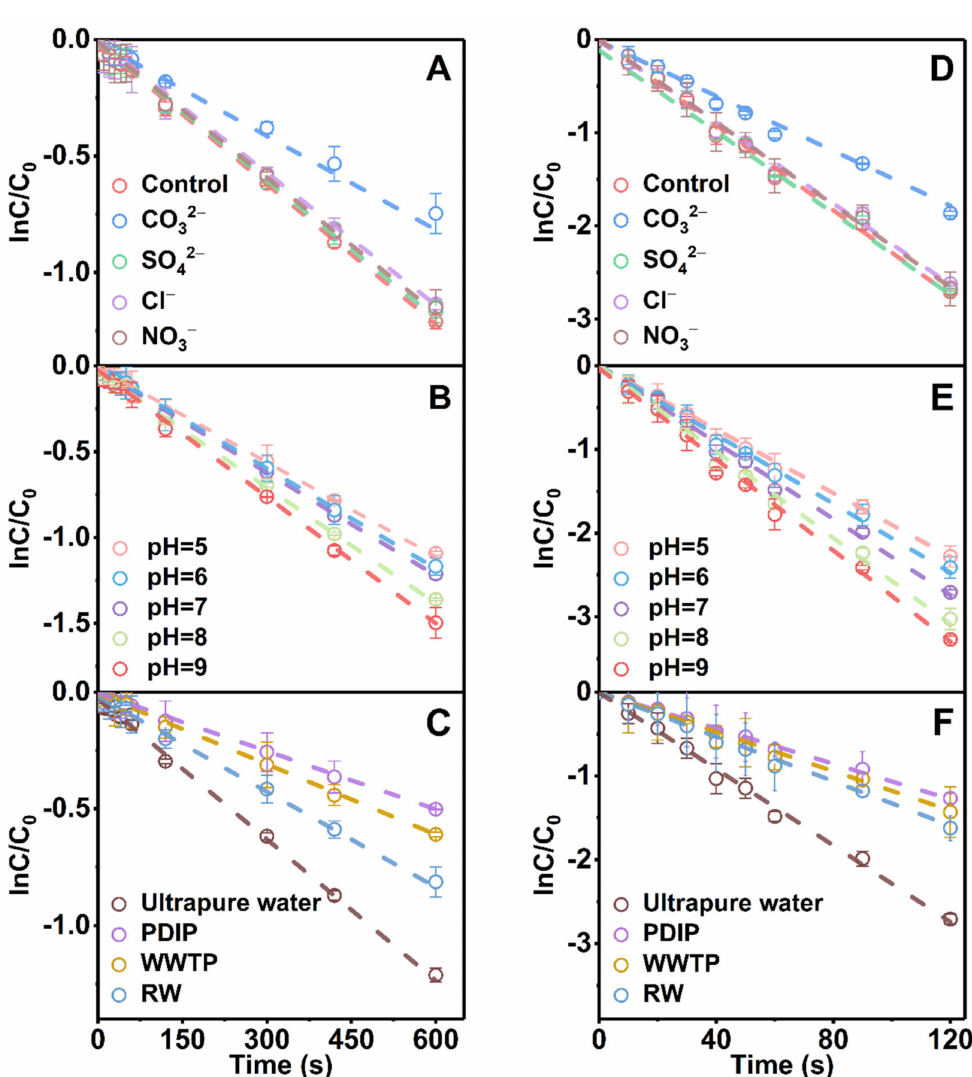
Figure 5. The degradation of DMP and 1 − NP in presence of different ions (CO 32 − , SO 42 − , Cl − , NO 3 − , 2 mM) ( A , D ), at pH of 6 − 9 ( B , E ), in different real water samples (ultrapure water, PDIP effluent, WWTP effluent, RW) ( C , F ). Conditions: [O 3 ] = 0.04 mM, [catalyst] = 200 mg L − 1 , the molar ratio of Fe/Mn = 1.5, [DMP]/[1 − NP] = 50 µ M, 2 mM phosphate buffer. Details are described in Text